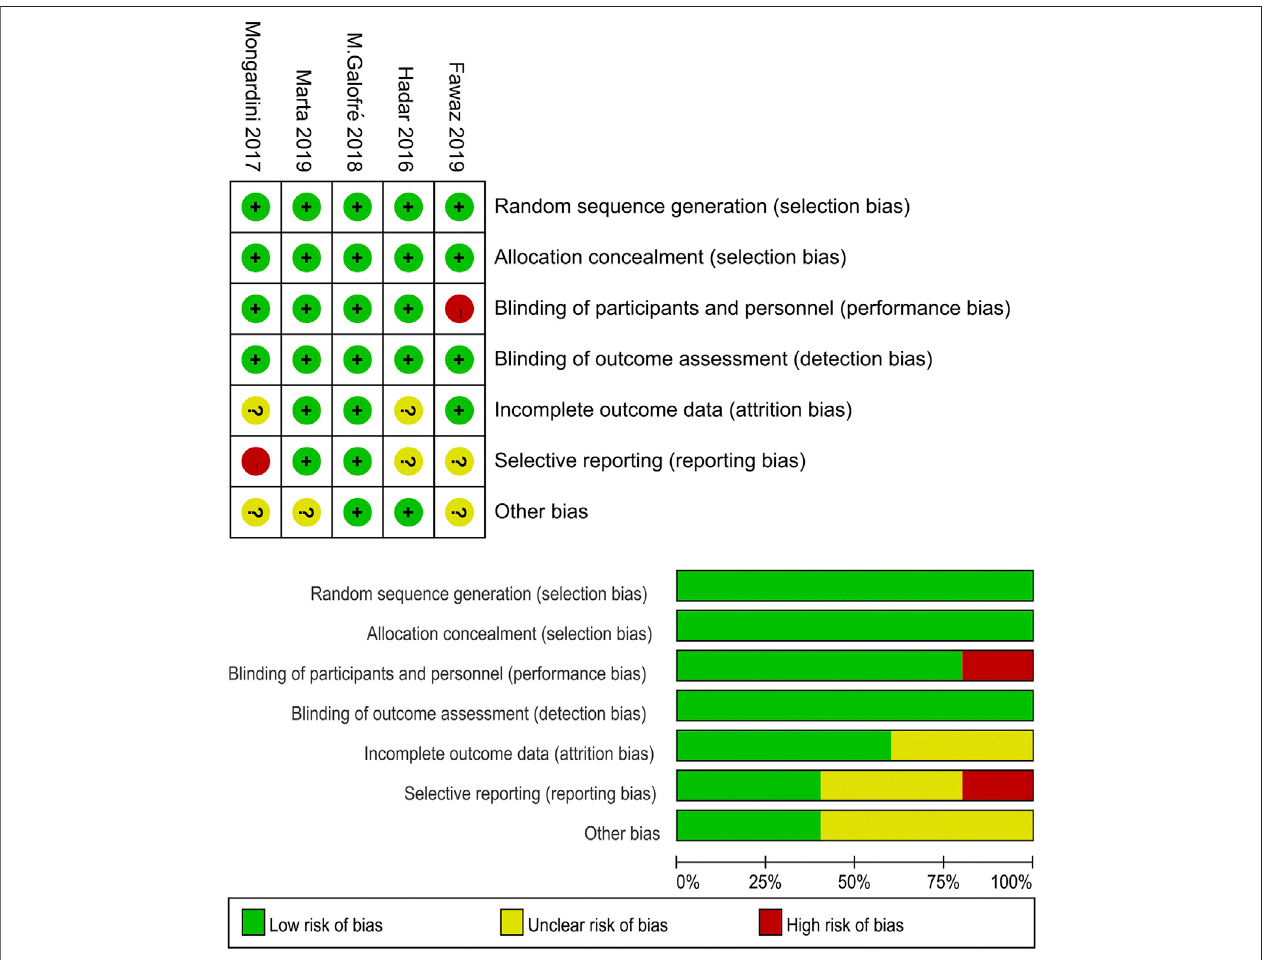
FIGURE 2 | Quality assessment of the selected studies (The Cochrane Collaboration tool for assessing risk of bias).